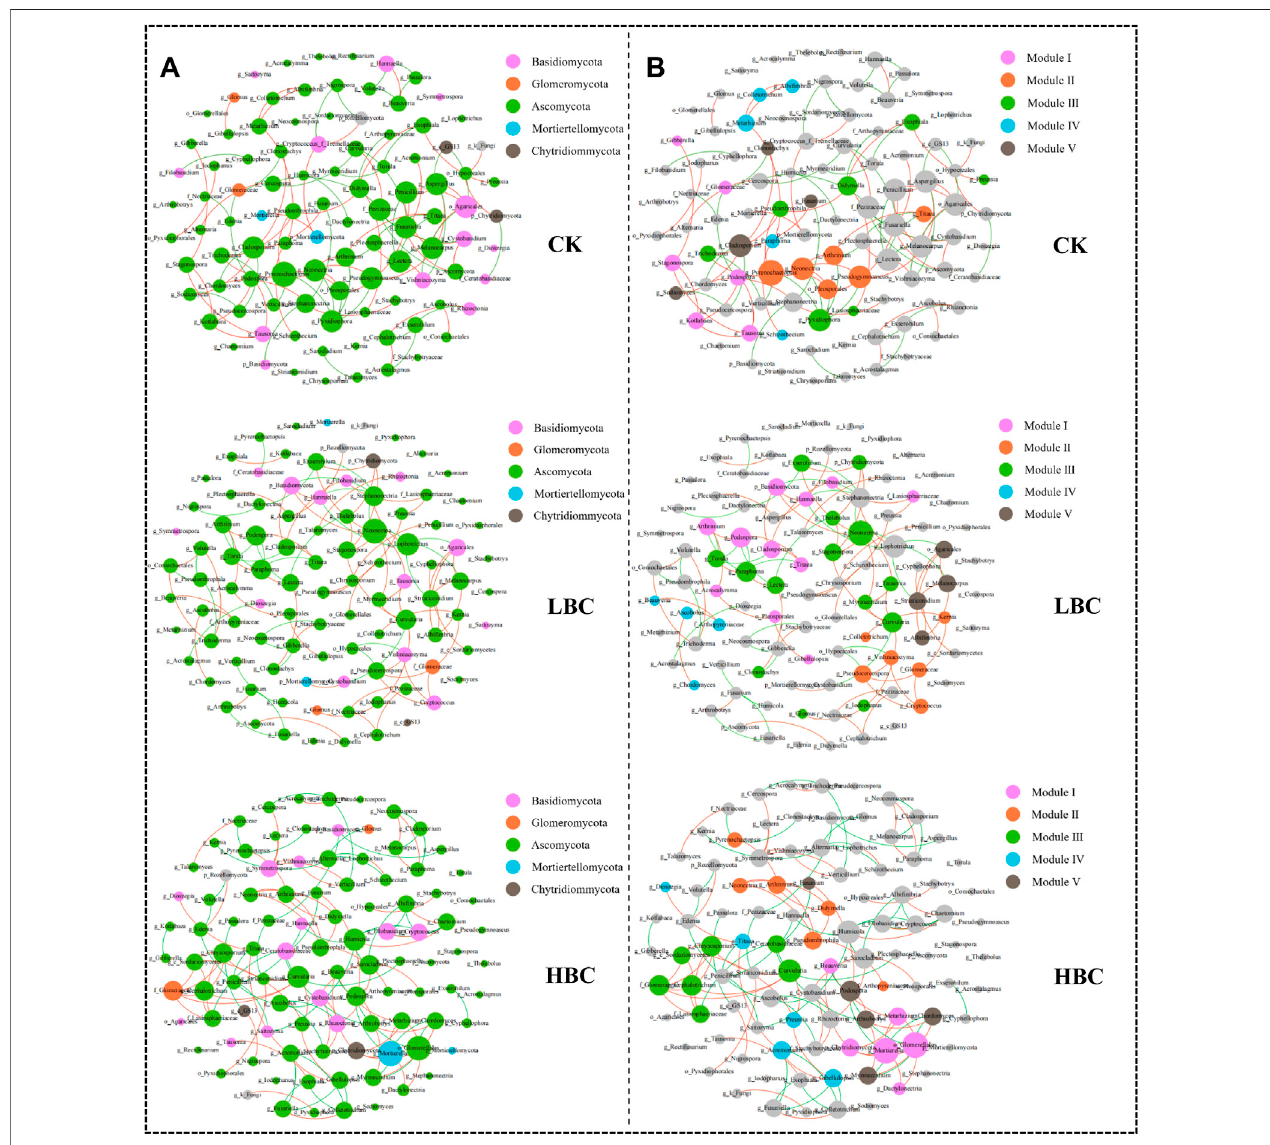
FIGURE 5 | The fungal co-occurrence networks (at the genus level) based on correlation analysis. The visualized connections reveal strong (Spearman ’ s p > 0.9) and signi fi cant ( p value < 0.01) correlations. Fungal networks are colored by phyla (A) and modules (B) , respectively. The modules I – V in the networks stand for the fi ve clusters of closely interconnected nodes. The node size is proportional to the connection number (degree), and the connection thickness is proportional to Spearman ’ s correlation coef fi cient values. The red and green edges indicate positive and negative interactions between two nodes, respectively. The keystone taxa were identi fi ed according to the module hubs. CK, soil without biochar amendment; LBC, soil amended with a low amount of biochar at 18 t/ha; HBC, soil amended with a high amount of biochar at 36 t/ha.